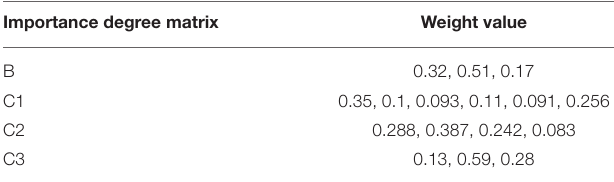
TABLE 2 | The distribution of weight values among the elements of the layers.